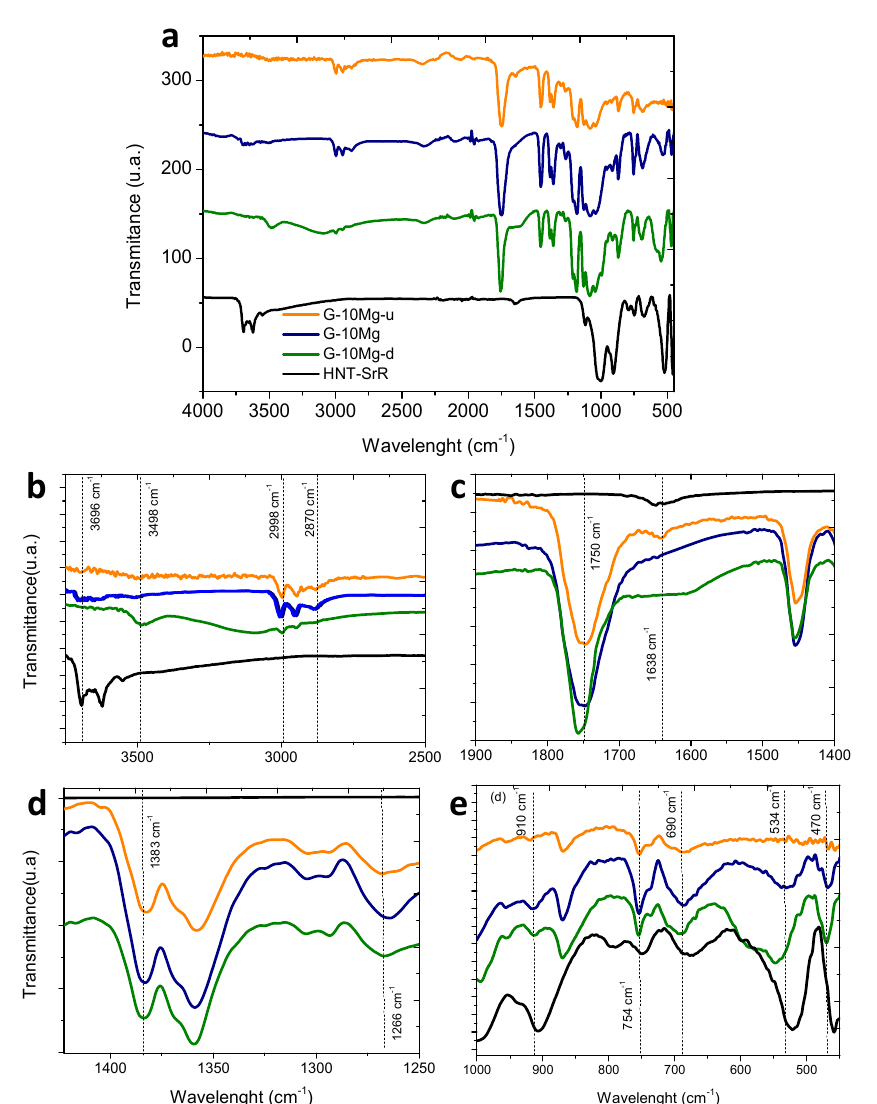
Figure 5. Depicts the complete FTIR spectra of HNT-SrR, G-10Mg-u, G-10Mg, and G-10Mg-d granules ( a ) and some representative bands associated ( b , c , d and e ).